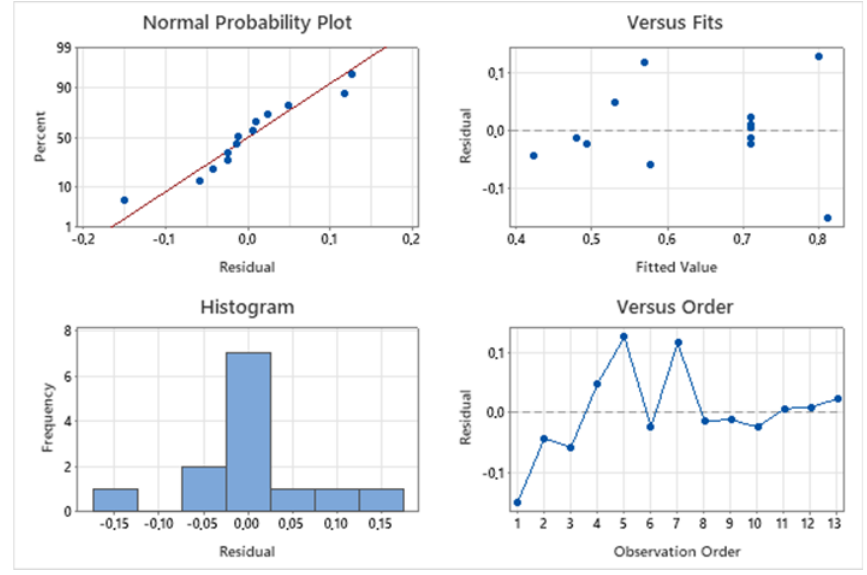
Figure 11. Residual plots for oil removal (%).